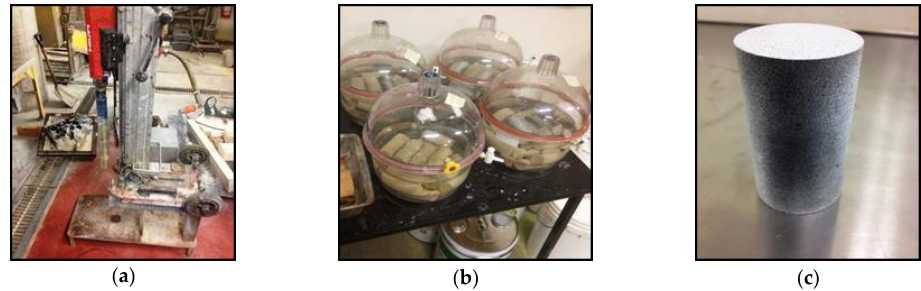
Figure 1. ( a ) Coring machine used to core the sample with 38 mm diameter, ( b ) Samples saturated with different fluids under vacuum in saturation chambers, and ( c ) Shaped and painted sample soon before the strength tests.